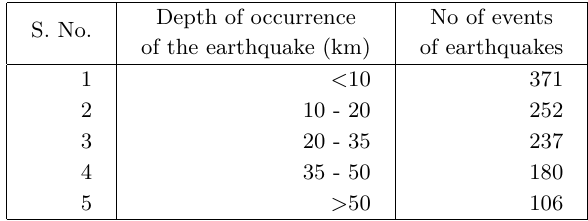
Table 1. Number of earthquake events occurred within the radius of 50 km of the landslide location at different depths.